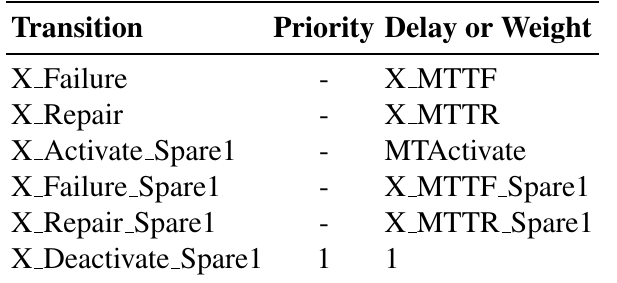
Table 1. Cold standby model: transition attributes. MTTF, mean time to failure; MTTR, mean time to repair; MTActivate, mean time to